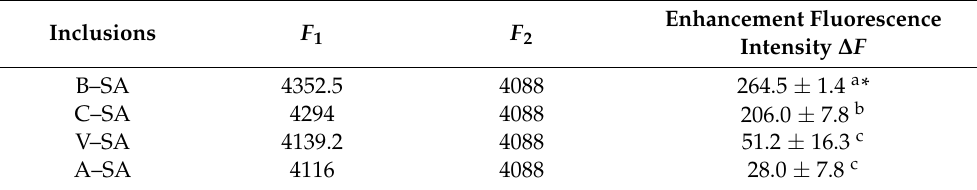
Table 2. Enhancement of fluorescence intensity of the four inclusions (A–SA, B–SA, C–SA, and V–SA) in comparison to